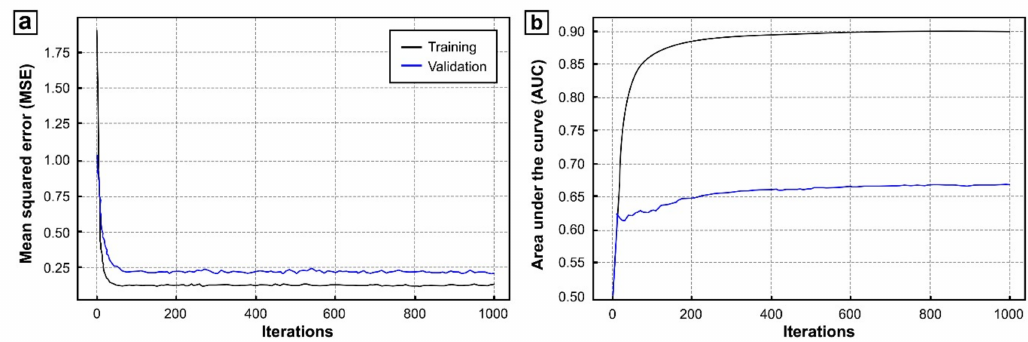
Figure 6. Example of training results generated for 500-m grid cells comparing ( a ) mean squared error and ( b ) area under the curve against number of iterations for a radial basis function neural network with 120 RBFs. The number of input vectors is 94 (70% of dataset) and 40 (30%) for training and validation,